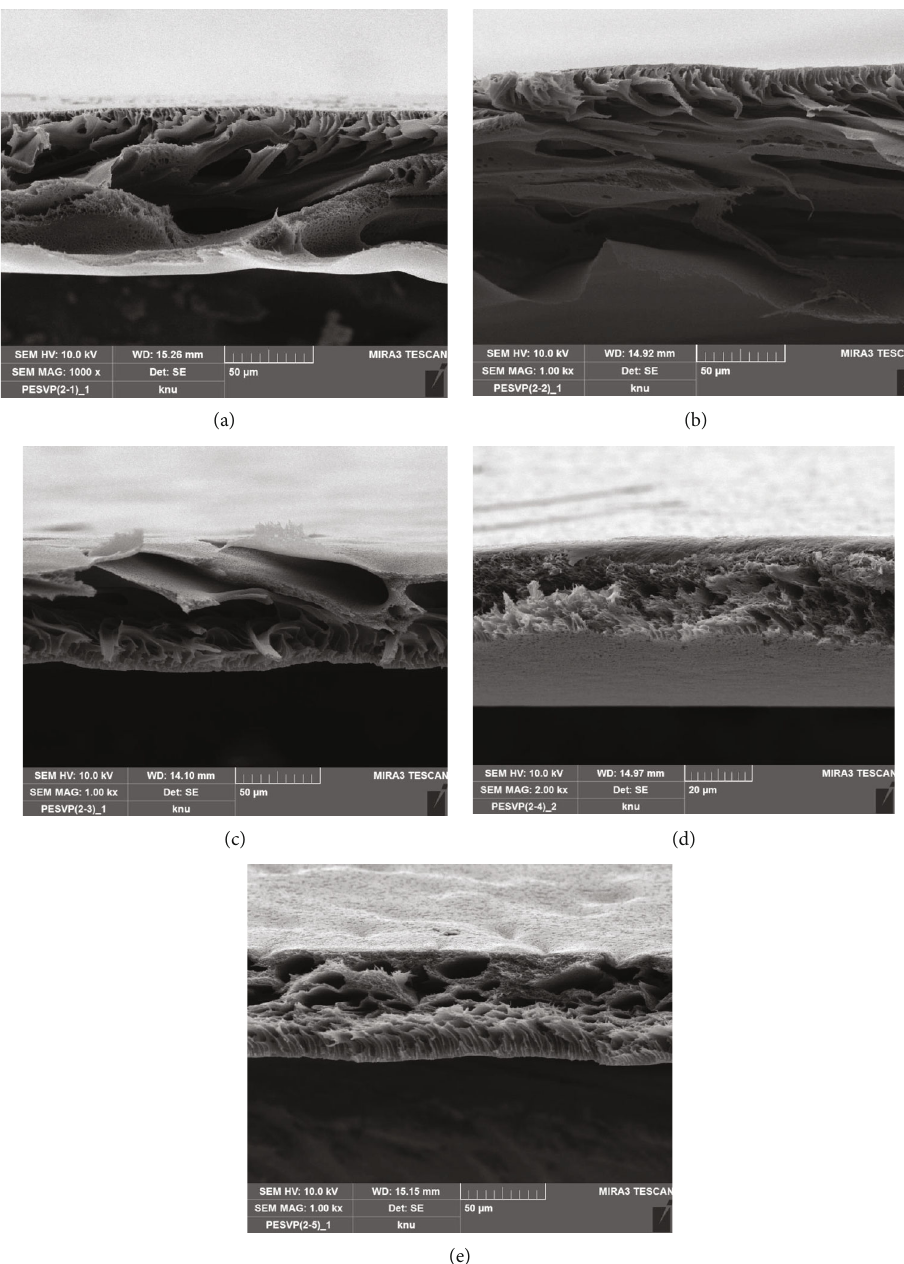
Figure 4: SEM image of PESVP membranes cross-section: (a) PESVP2-1; (b) PESVP2-2; (c) PESVP2-3; (d) PESVP2-4; (e)